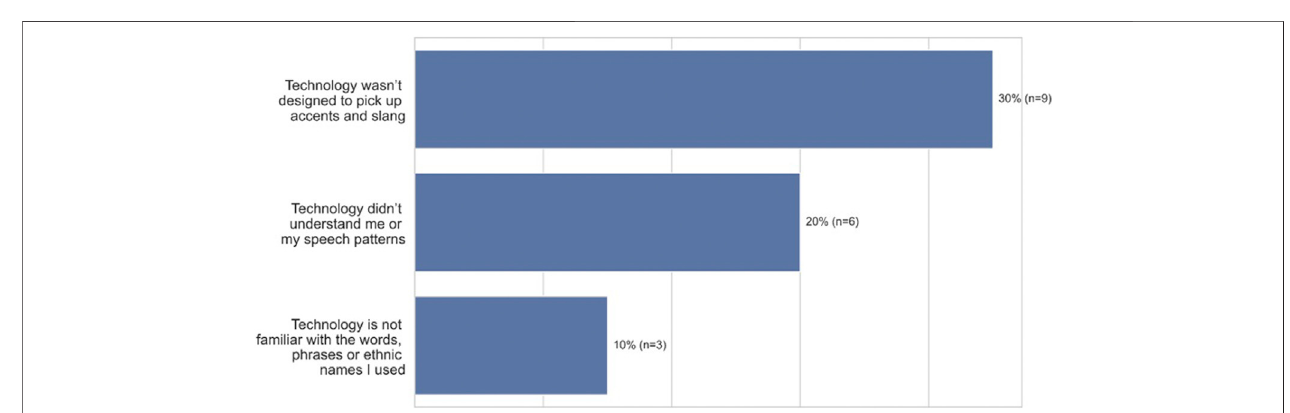
FIGURE 3 | Top three attribution of errors among African-American participants when using ASR technology ( n (cid:1) 30).